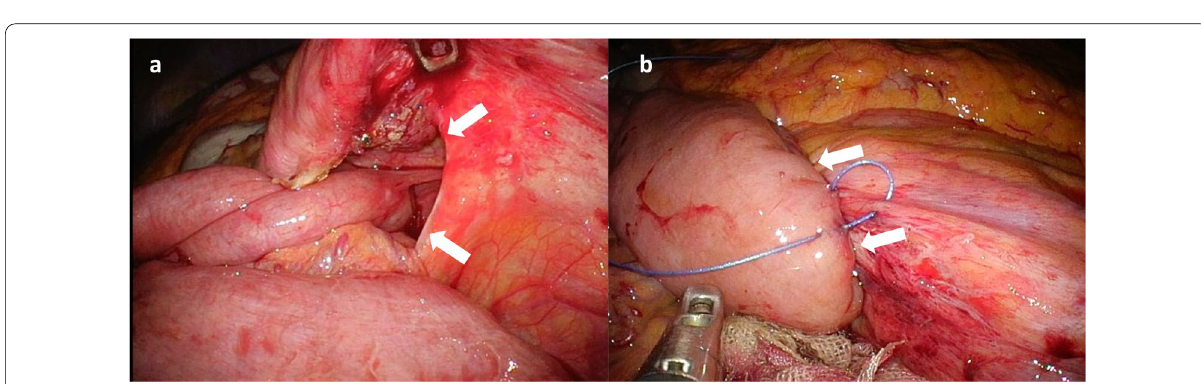
Fig. 3 Images during surgery. a Landzert’s fossa (white arrow) was revealed after the reduction of the hernia contents. b Closing of the defect (white arrow) by